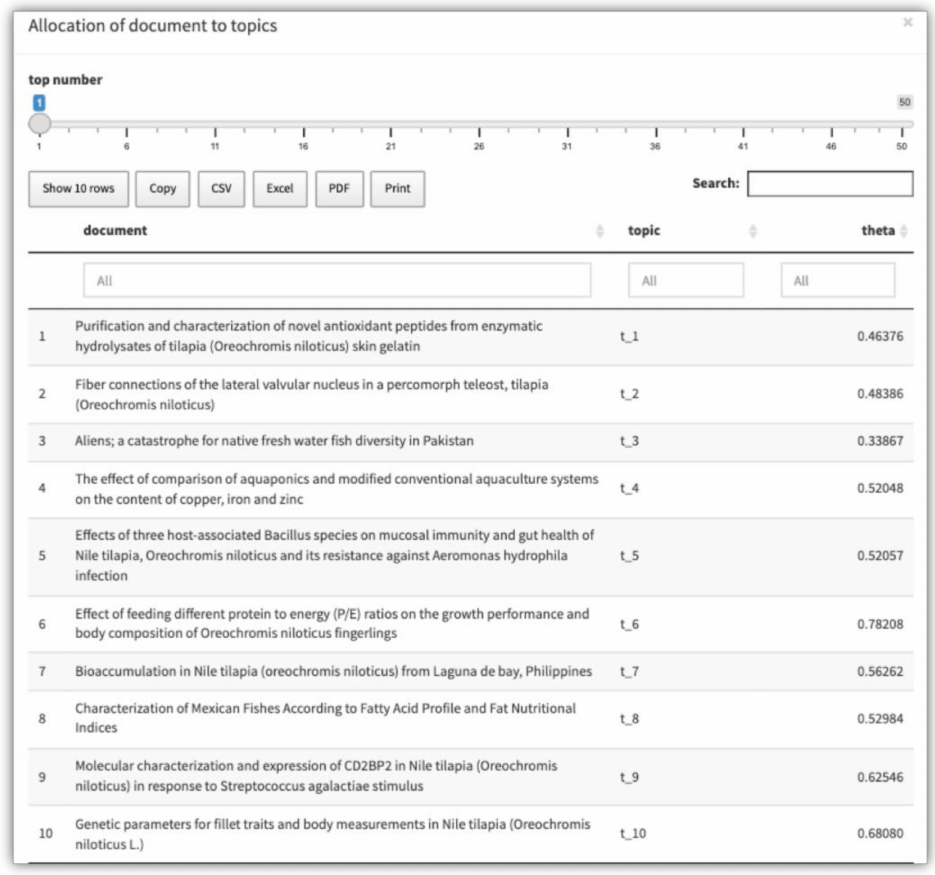
Figure 11. Output tabular